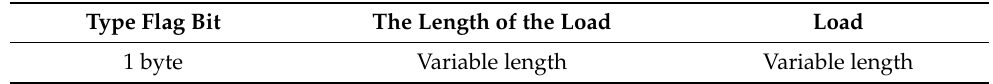
Table 3. General form of ASN.1.